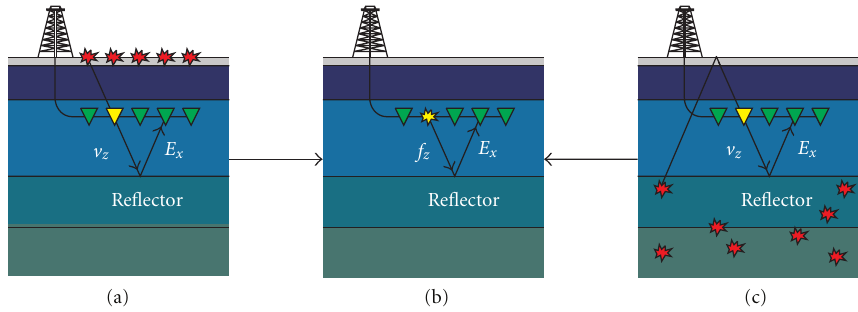
Figure 12: Schematic seismoelectric interferometry setting. Cross-correlation of electric ( E x ) and acoustic signals ( v z ) from sources located at the surface (a) or in the bulk (c) results in the direct electric response of an acoustic source ( f z ) generating a seismoelectric wave (b).